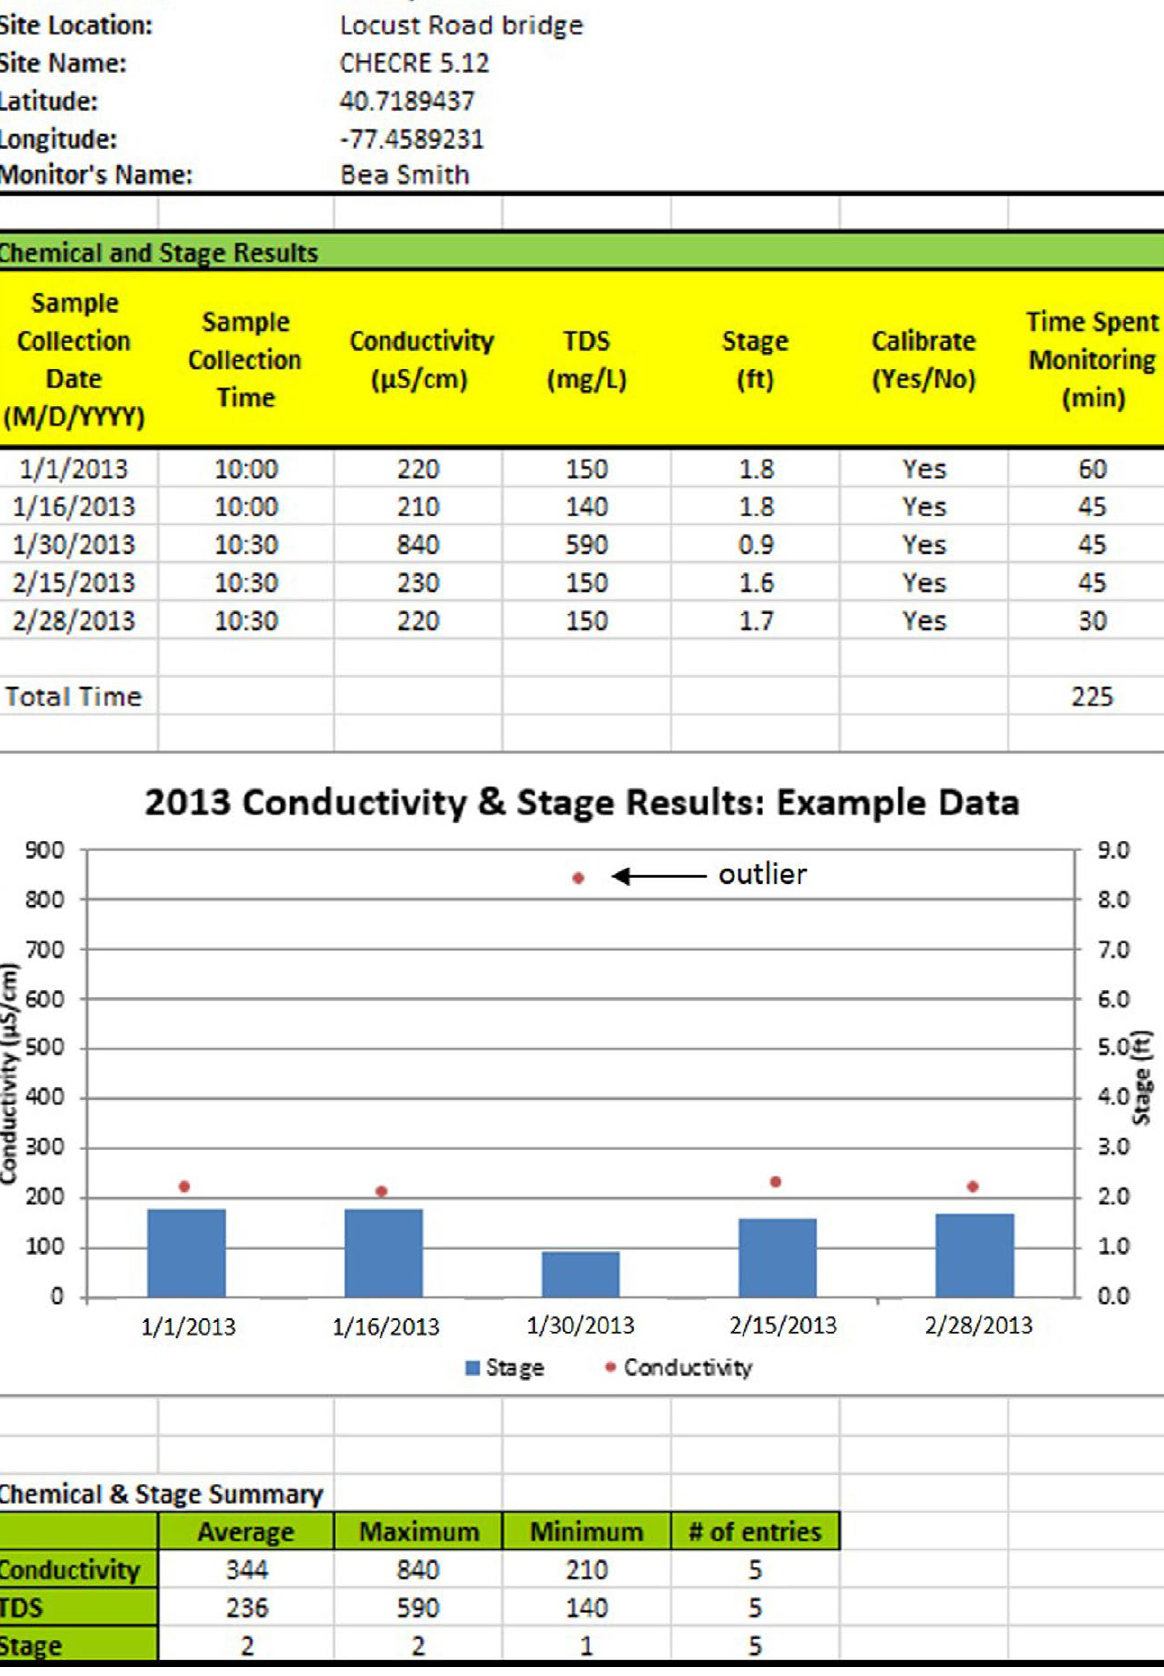
Figure 5: The Excel spreadsheet used by volunteers to compile chemical and stream stage data from a single site and to identify pollution events (outliers). This spreadsheet also has columns for visual assessment records (ALLARM